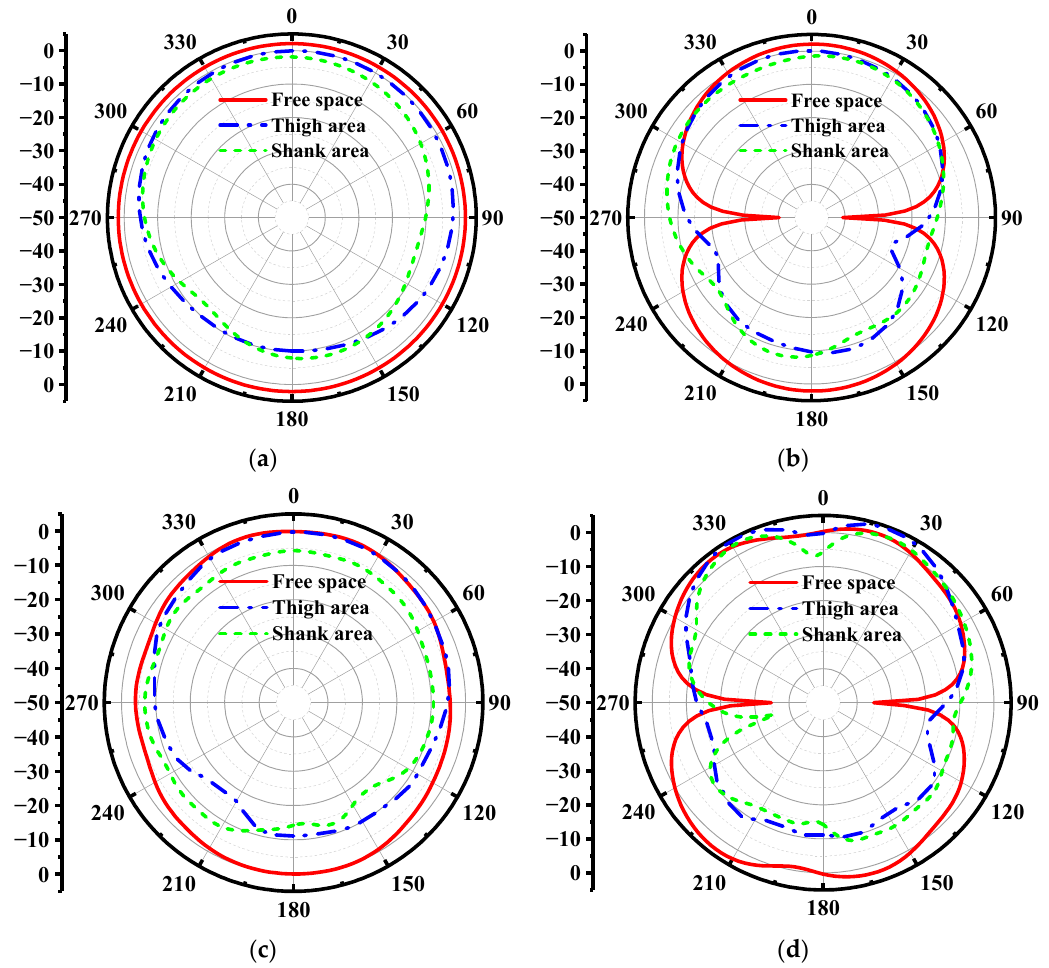
Figure 12. The radiation patterns of the wearable antenna in free space, thigh area and shank area. ( a ) 0.4 GHz in xoz plane. ( b ) 0.4 GHz in yoz plane. ( c ) 1.2 GHz in xoz plane. ( d ) 1.2 GHz in yoz plane.